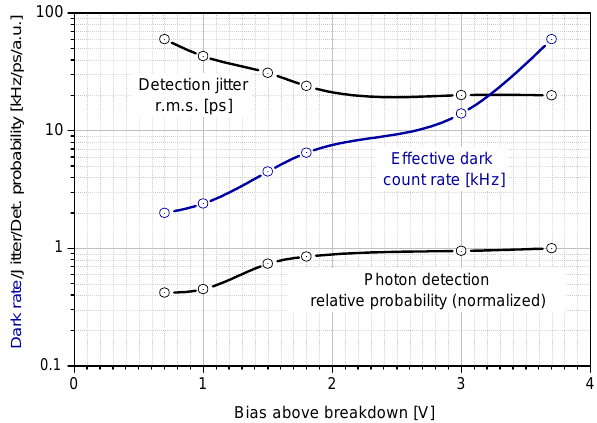
Figure 8. Three important and interconnected parameters of typical 200 µm K14 sensor cooled at − 60 °C plotted against the bias